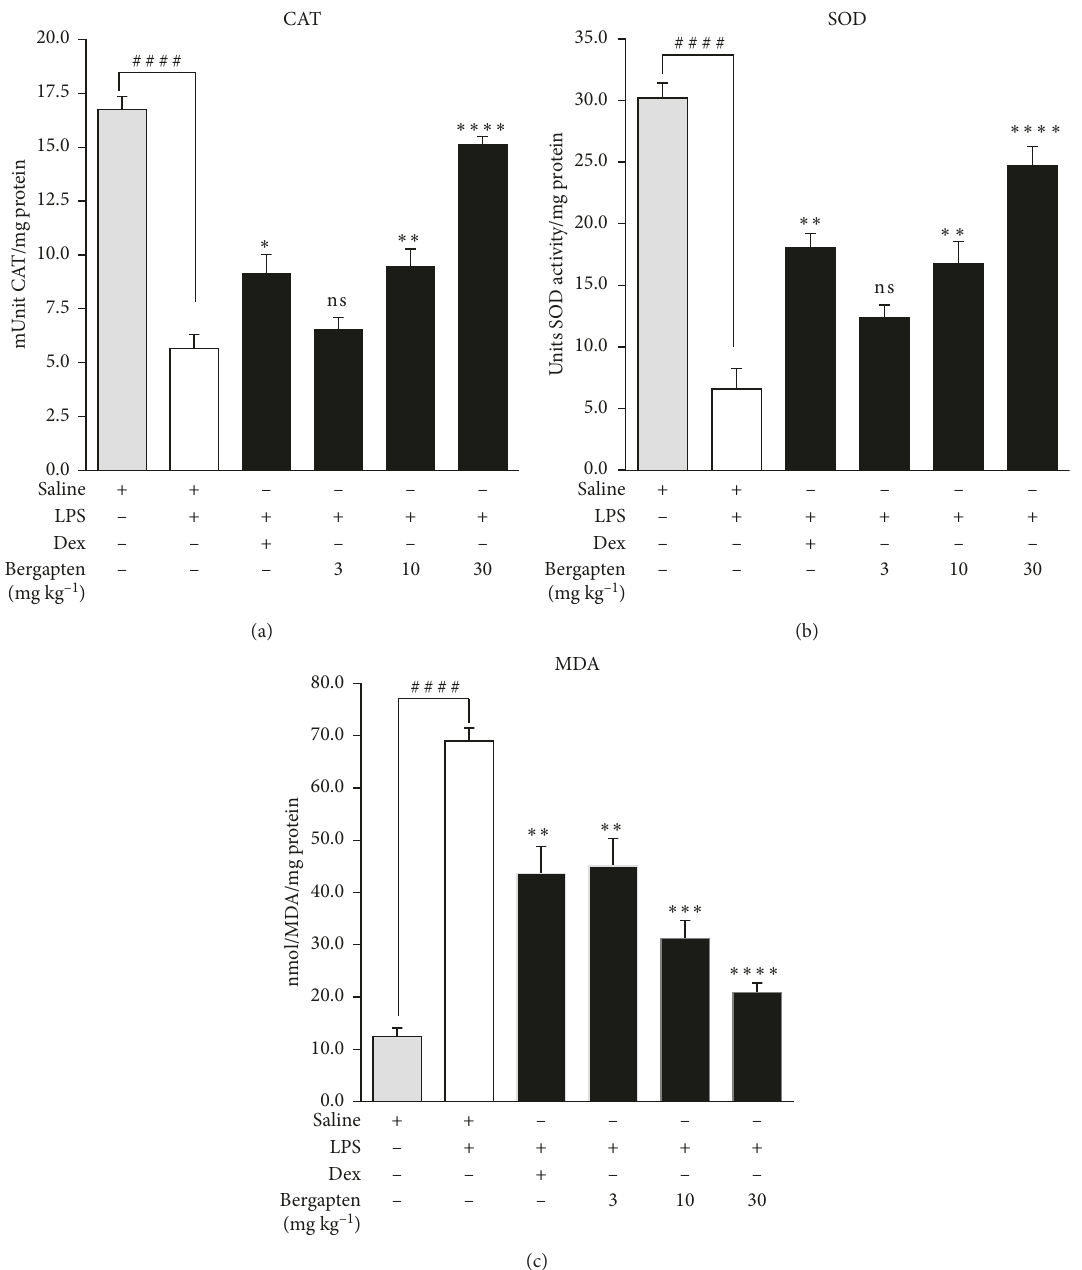
Figure 5: Effect of bergapten on oxidative stress markers in LPS-induced lung inflammation. C57BL/6 mice were treated with either saline 10ml kg − 1 , dexamethasone 10mgkg − 1 , or bergapten 3–30mg kg − 1 for 1h. Test mice were challenged with LPS and sacrificed 24h later. Lungs were harvested, processed, and supernatant analyzed quantitatively for catalase (CAT) (a), superoxide dismutase (SOD) (b), and malondialdehyde (MDA) (c). Data are expressed as mean ± SEM ( n � 5). ∗ p < 0 . 01, ∗∗ p < 0 . 01, and ∗∗∗∗ p < 0 . 0001 compared to saline- treated LPS-challenged disease control. #### p < 0 . 0001 compared to na¨ıve control (one-way ANOVA followed by Dunnett’s post hoc test). ns is not